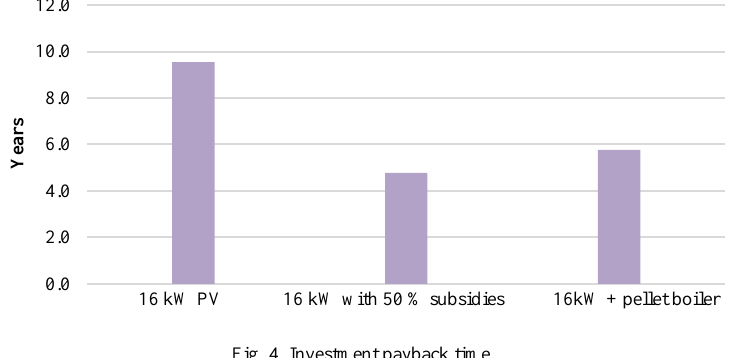
Fig. 4. Investment payback time.